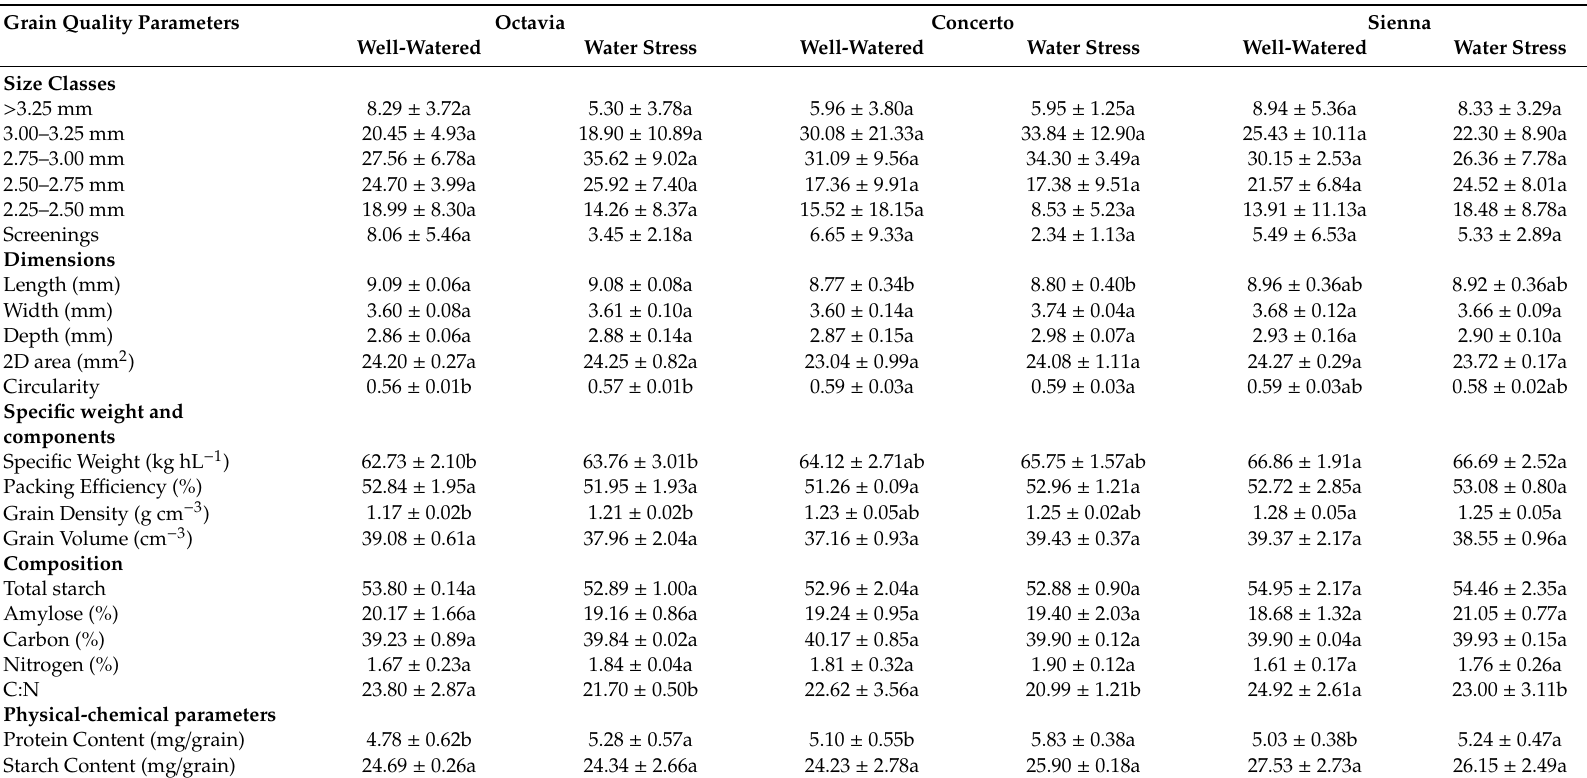
Table 1. Summary of mean values ± standard deviations for grain quality parameters across three reps for the three cultivars and two treatment levels used in this study 1